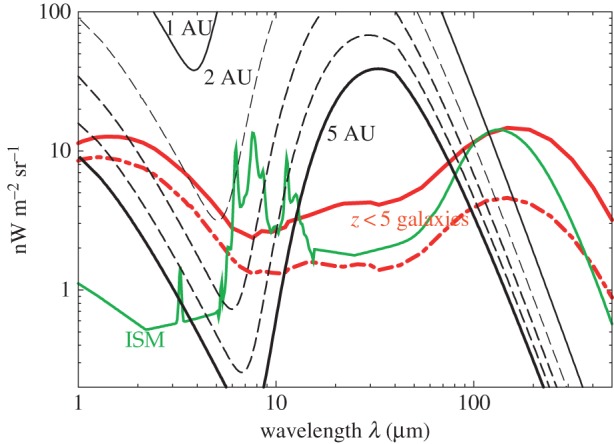
Zodiacal light intensity as a function of the radial distance from the Sun, based on the Pioneer 10 dust density estimates [112] normalized to a radial profile from the Sun of r−1.5. For reference, we also show the optical to near-IR spectrum of the Galactic interstellar medium (ISM) and two predictions from semi-analytical models on the total IGL from z<5 galaxy populations (adapted from Primack et al. [113]). The zodical light intensity estimates as a function of the radial distance are based on the calculations for ZEBRA concept instrument for the outer Solar System in Cooray et al. [114].